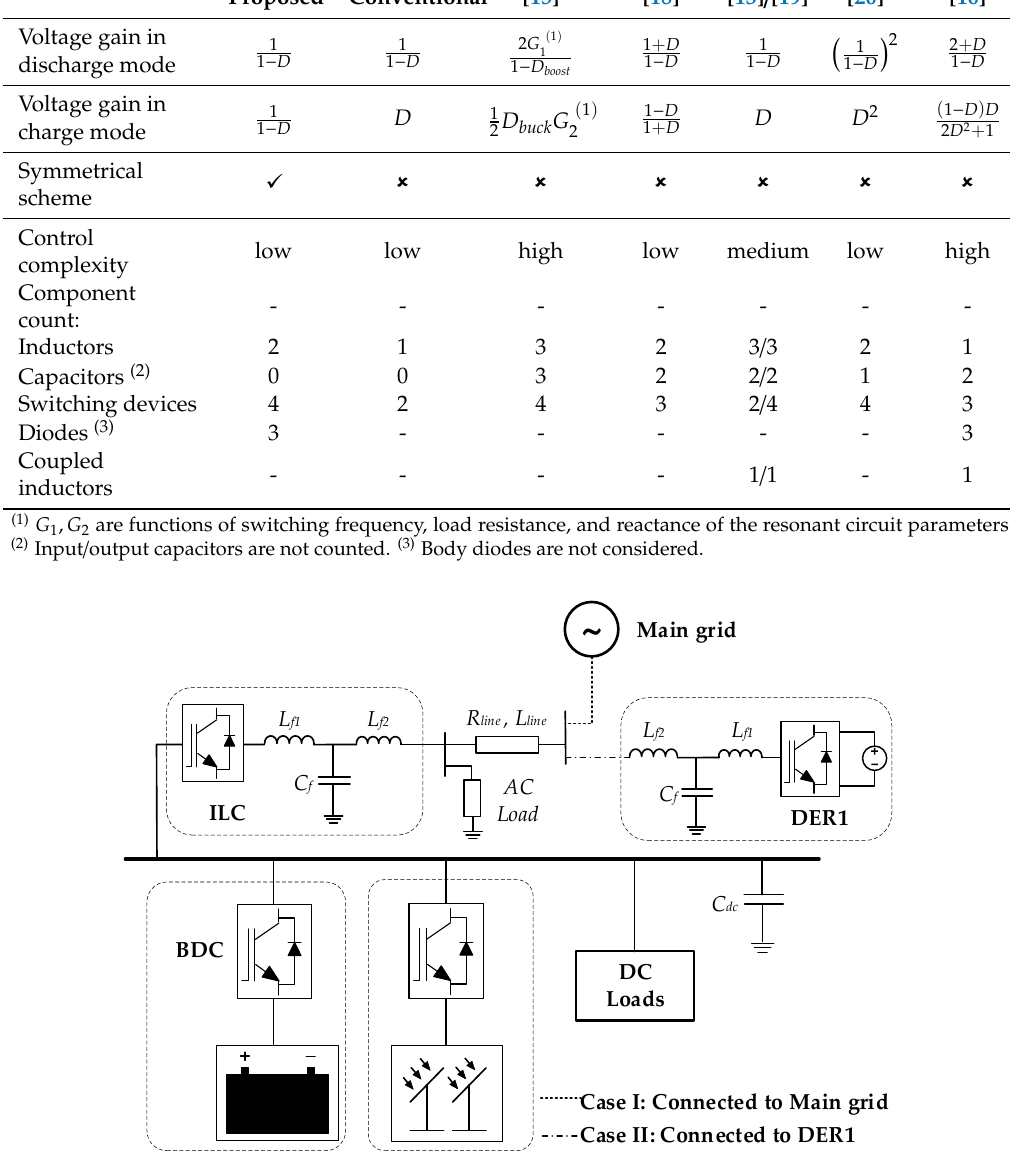
Table 1. Comparison between proposed, conventional, and other bidirectional DC-DC converters (BDCs).